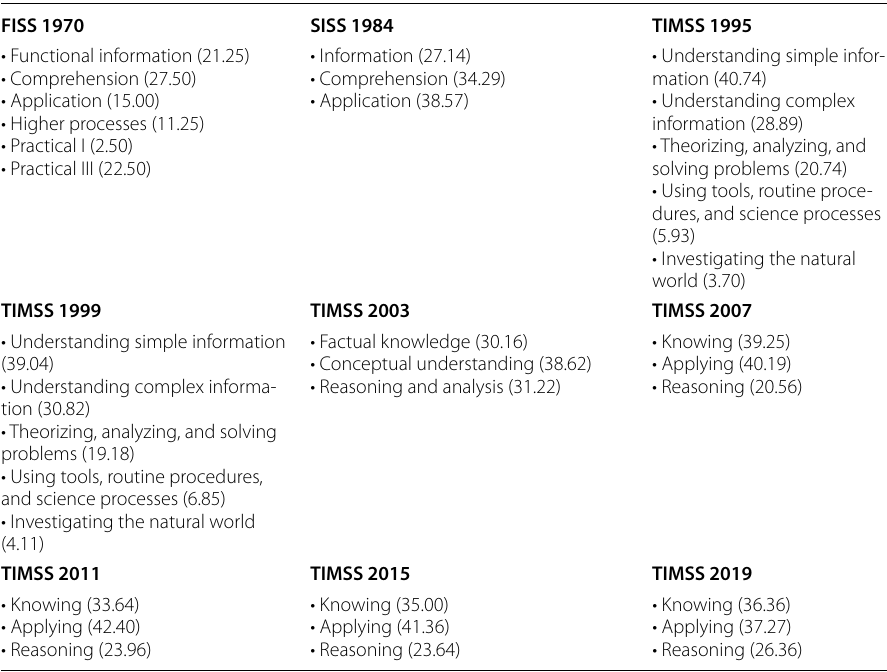
The percentage of items is shown in